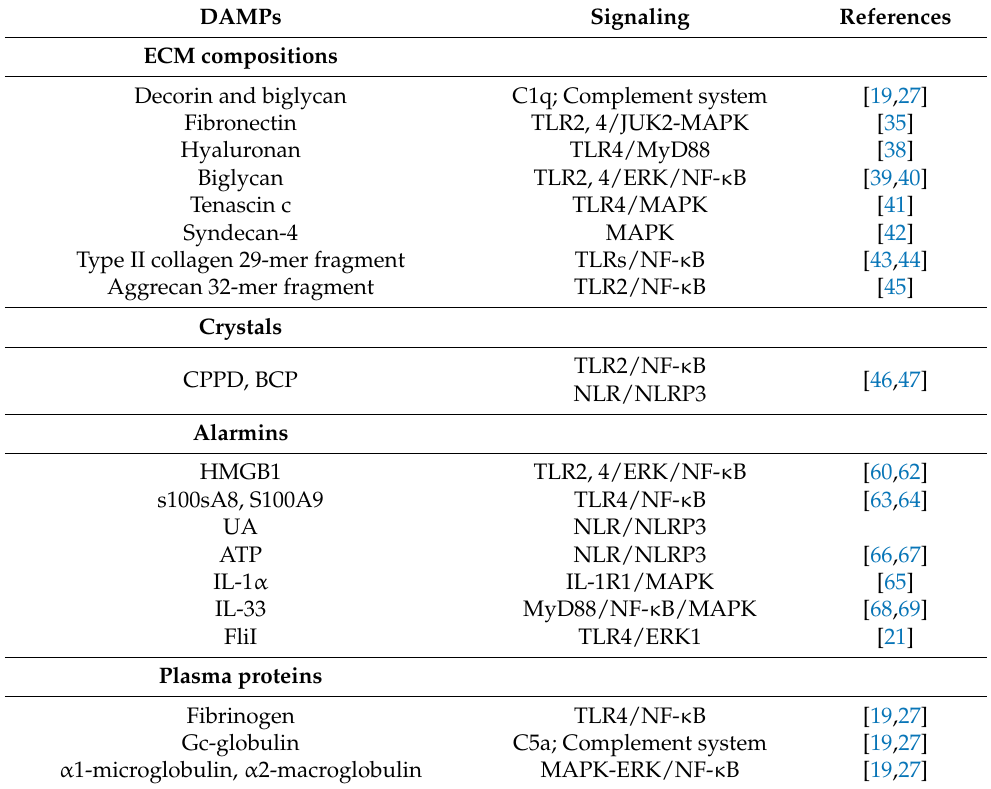
Table 1. DAMPs and their signaling pathways are implicated in inflammation and OA